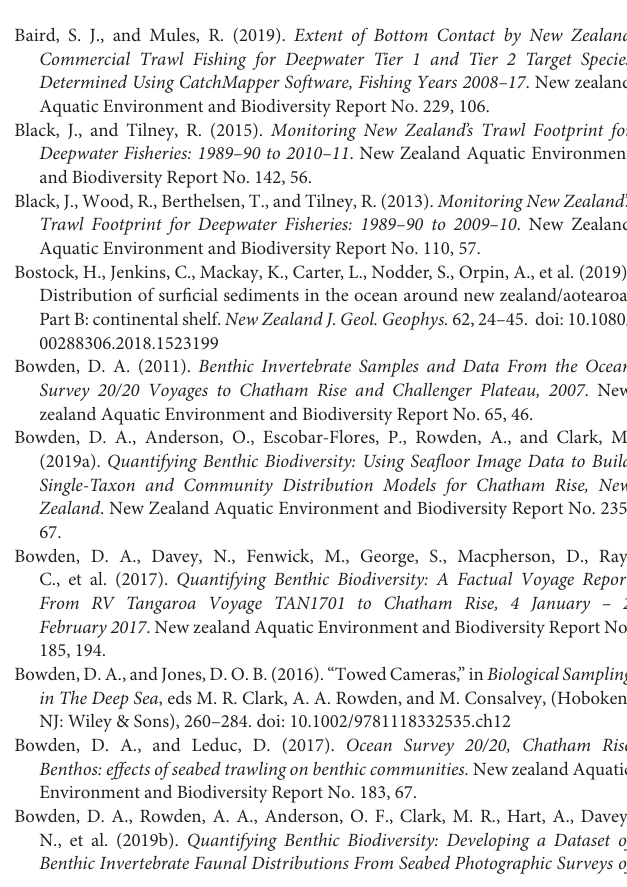
Supplementary Figure 1 | Illustration of prevalence calculation, showing the seabed track of a video transect (Voyage TAN0705, station 170) divided into 10-min segments (alternating blue–red), with individual observations of the taxon Paguridae (hermit crabs) indicated by black circles. Prevalence is calculated as the proportion of the total number of segments in which the taxon was observed, in this case 8/12 = 0.66. Also shown are the density of Paguridae as individuals 1,000 m − 2 , and the probability of suitable habitat as predicted by the BRT model of Compton et al. (2013). Supplementary Figure 2 | Variation in AUC and Sensitivity (true positive rate) with taxonomic resolution. (Left) AUC kvc (by cross validation, blue) and AUC ind (against independent data, red) values as described in Figure 3 , plotted by taxonomic level. (Right) Sensitivity (true positive rate) for all models when assessed against the independent data. Horizontal bars show mean values in each taxonomic level. Supplementary Table 1 | Author’s ranking of eight published SDM studies by reference to assessment criteria and issues proposed by Araujo et al. (2019). DB, David Bowden; OA, Owen Anderson; AR, Ashley Rowden; FS, Fabrice Stephenson. Rankings from best to worst are: g old (G); s ilver (S); b ronze (B), and d eficient